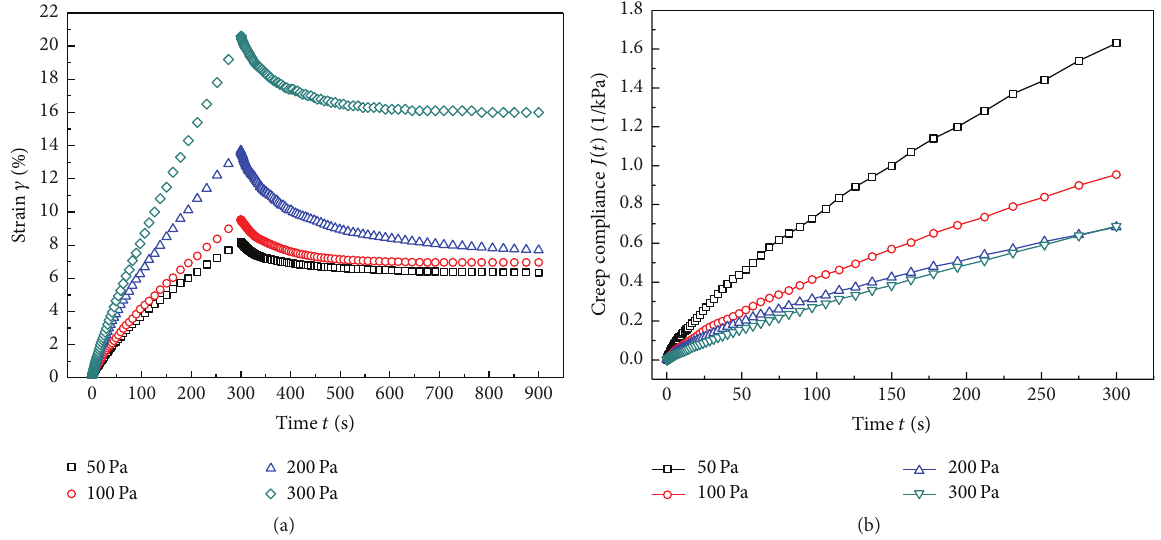
Figure 2: The creep characteristic of MRSP-4 on the condition of different initial stress and zero magnetic field: (a) creep and recovery phase and (b) creep compliance in creep